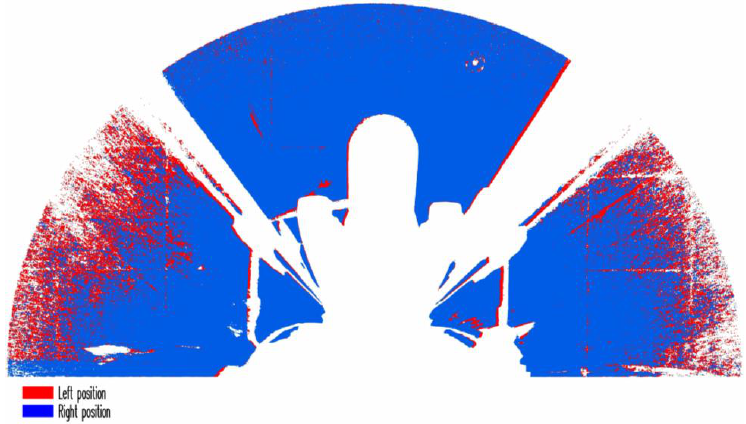
Figure 4. Merged clouds of points from the left and right scanner position converted to polygons (agricultural tractor).